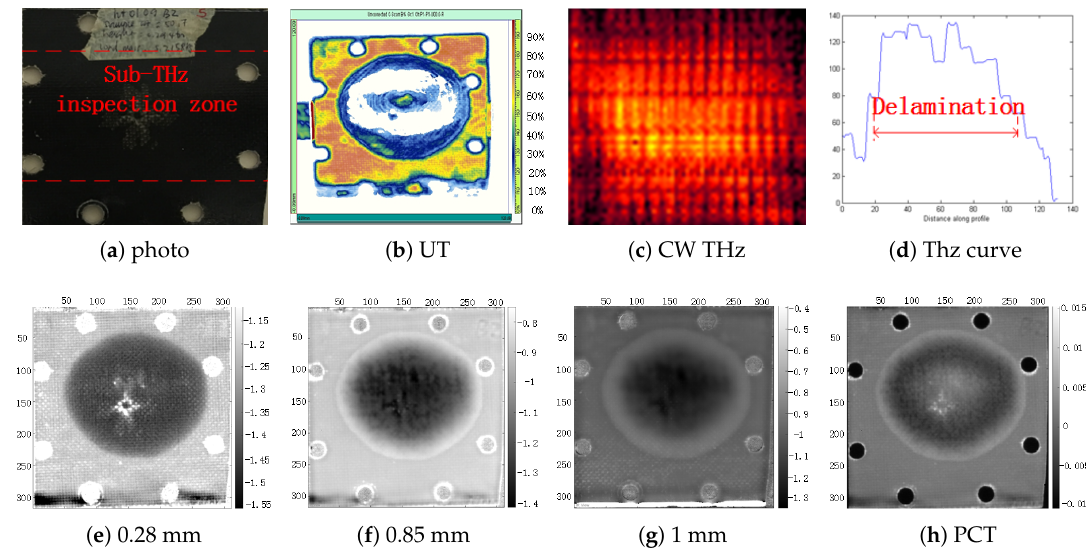
Figure 11. Front-side inspection for the BFRP laminate subjected to 15 J impact loading after PPT ( e – g ) and PCT